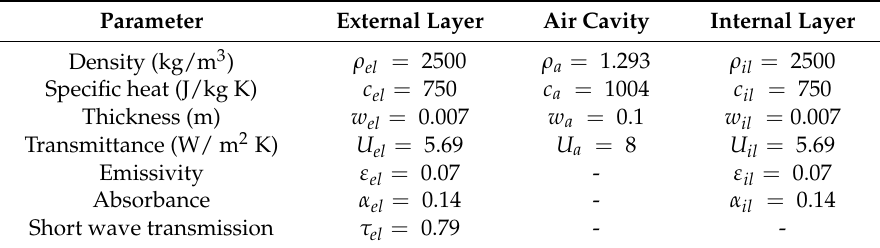
Table 2. Fixed parameters involved in (P façade ) problem.